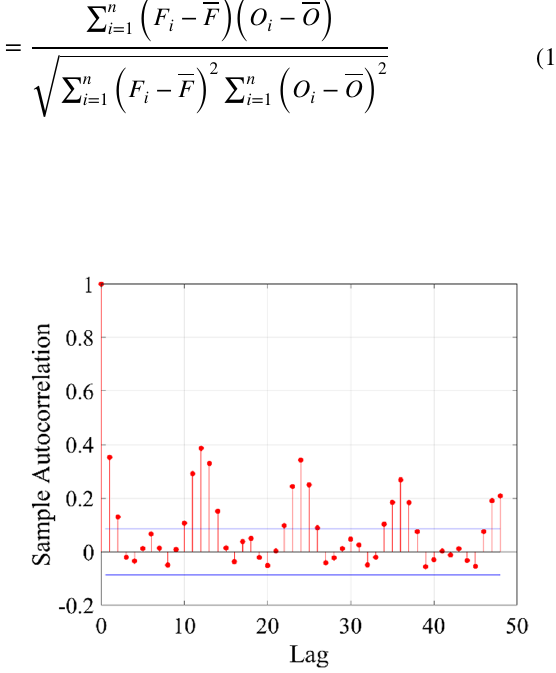
Fig. 2 ACF diagram of the Ardebil